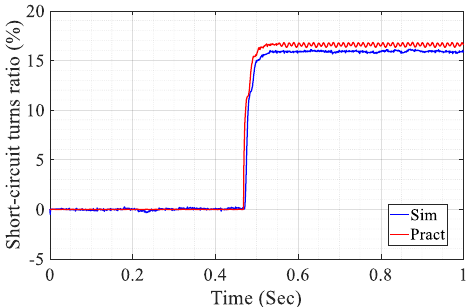
Figure 30. Estimation of 16% short circuit turns ratio in phase A.